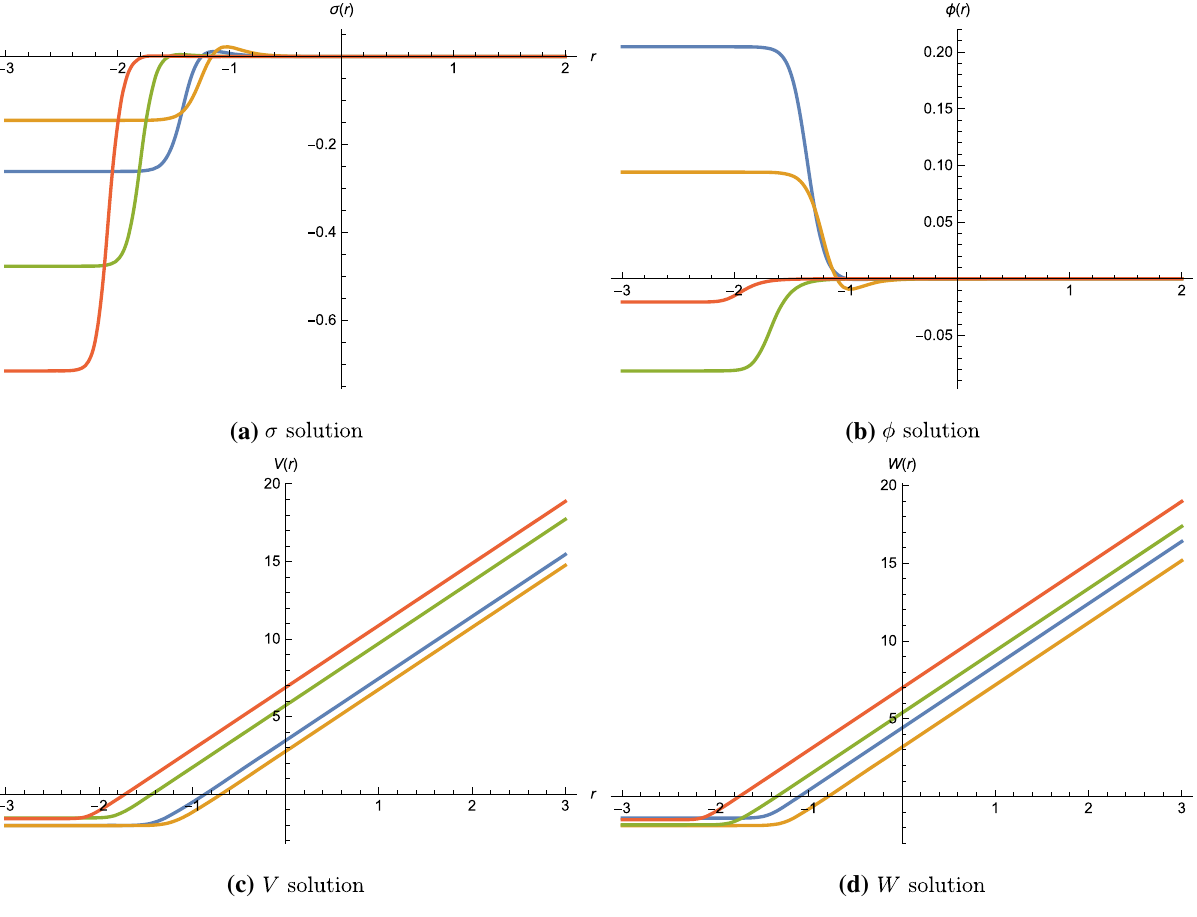
Fig. 2 RG flows from SO ( 4 ) N = ( 1 , 0 ) SCFT in six dimensions to two-dimensional N = ( 2 , 0 ) SCFTs with SO ( 2 ) × SO ( 2 ) symmetry dual